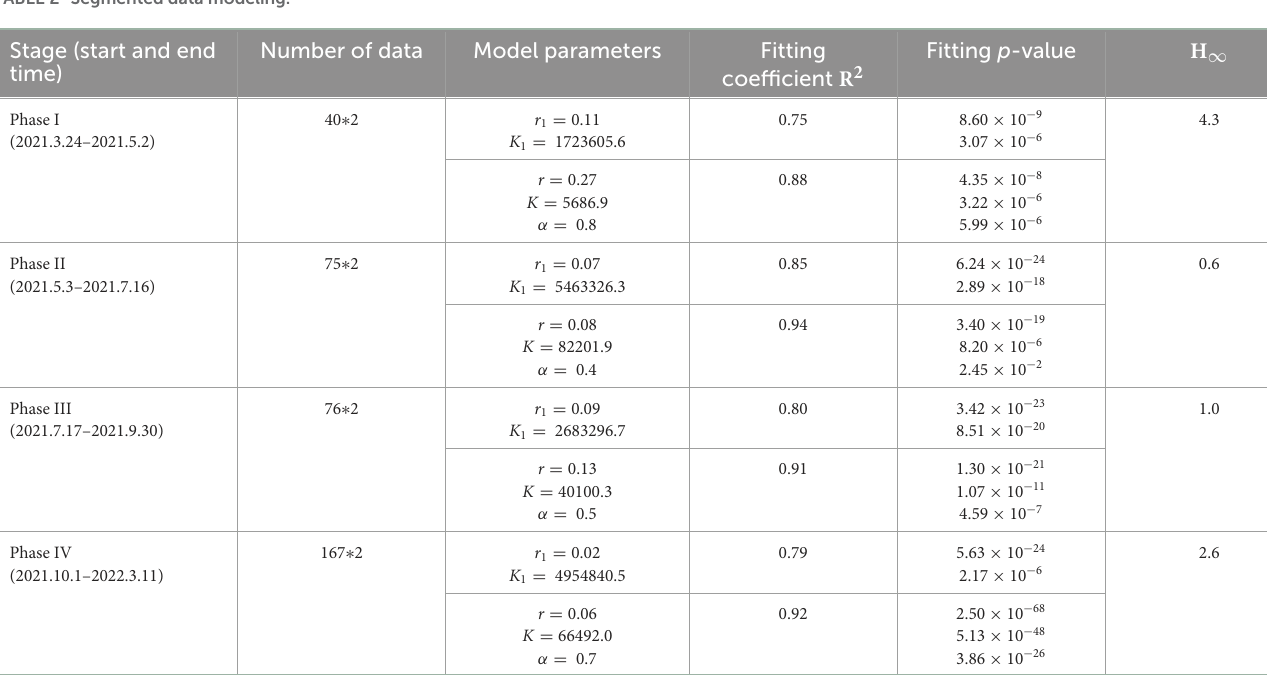
TABLE 2 Segmented data